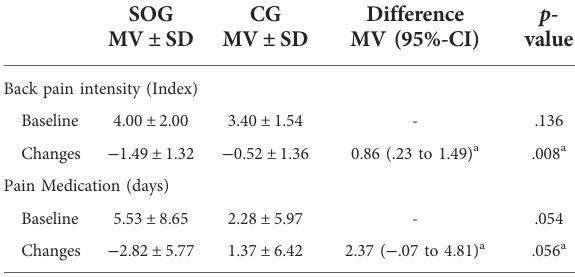
TABLE 3 Baseline values and changes of secondary outcomes of the spinal orthosis (SOG) and control group (CG). SOG